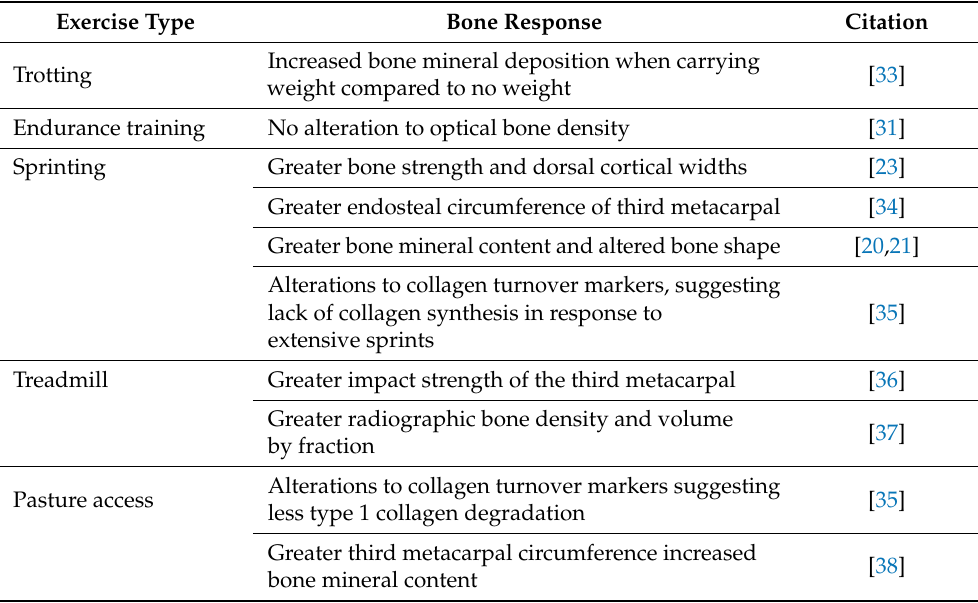
Table 1. Exercise type, and associated bone response in young